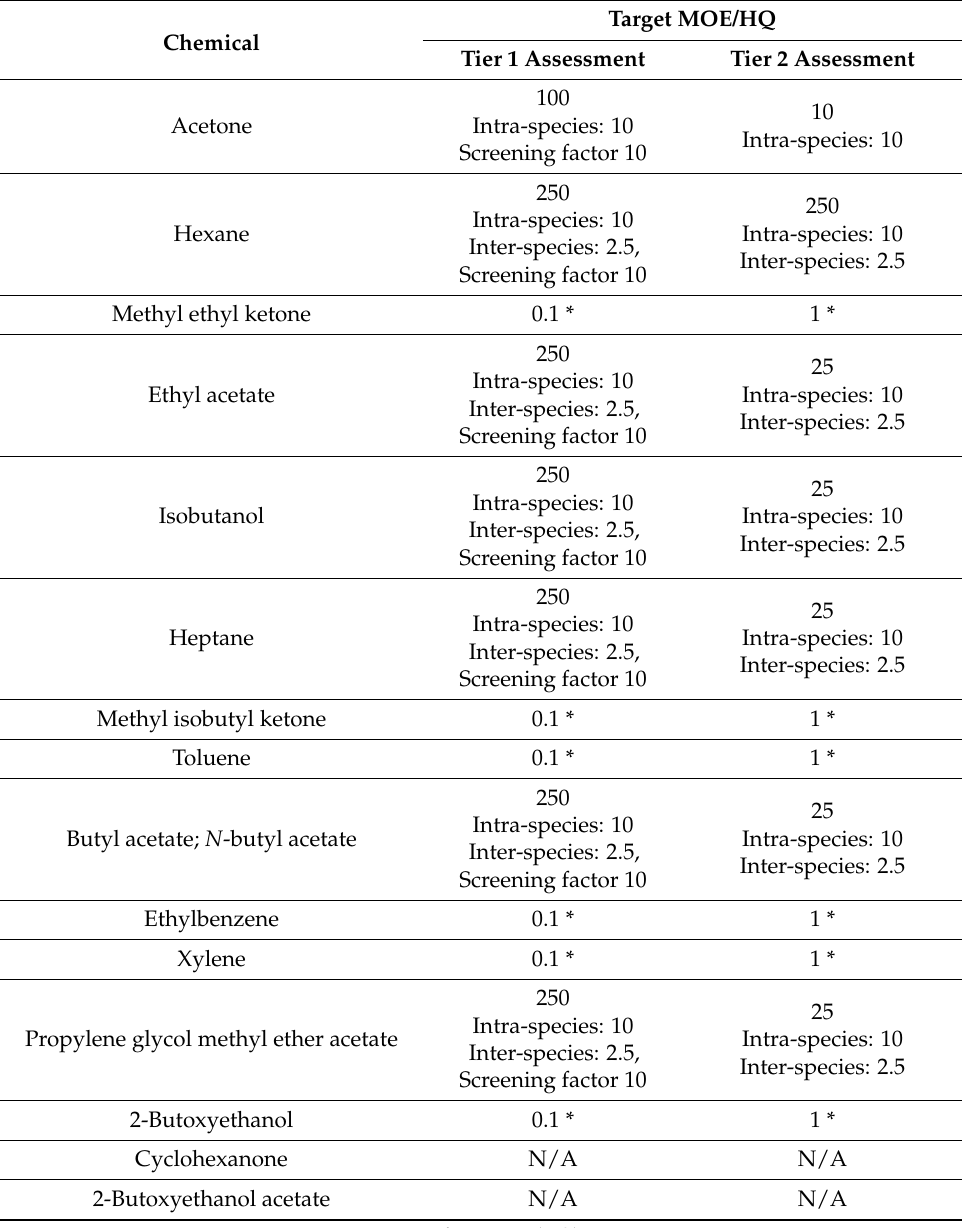
Table 5. Summary of Margin of exposure (MOE) and hazard quotient (HQ) for target chemicals from tier 1 and 2